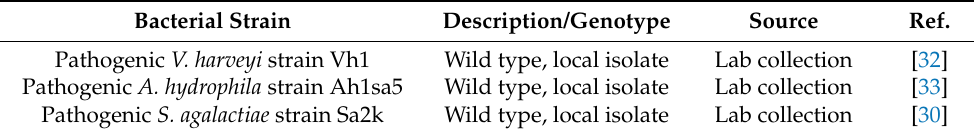
Table 1. Bacterial strains genotypes used in this study.